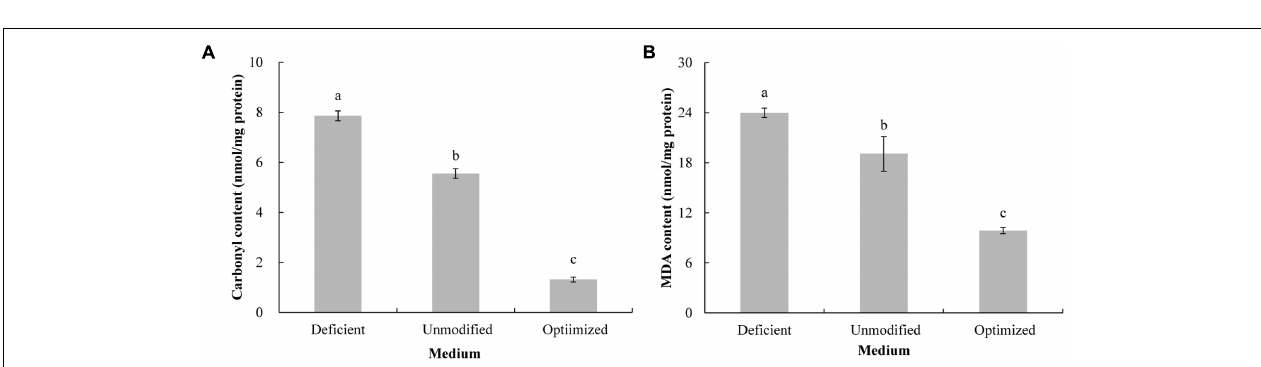
FIGURE 2 | Biomass production (g DW/L) (A) and viability (B) of Candida diversa after 96-h culture in three different media: unmodified minimal mineral (MM) medium, ion-deficient MM medium, and Mg 2 + , Fe 2 + , and Zn 2 + optimized MM medium. Data represent the mean ± SD of the pooled data from three experiments ( n = 9). Columns with different letters indicate significant differences according to a Duncan’s multiple range test ( P < 0.05).